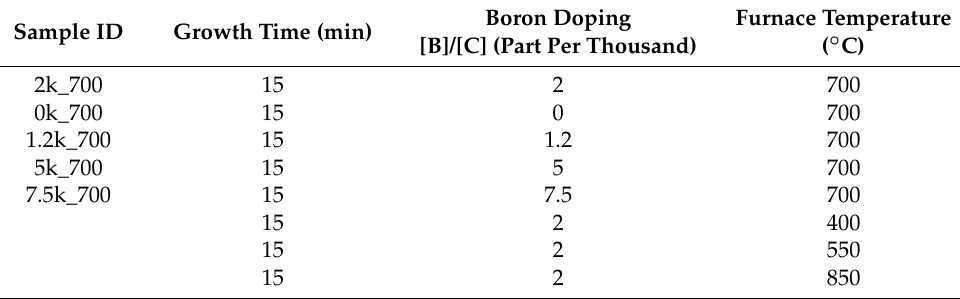
Table 1. Parameters of growth of boron-doped carbon nanowall (B-CNW) films. Sample